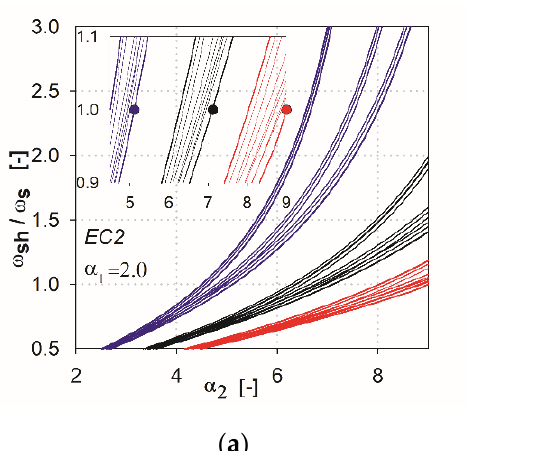
Figure 9. Graphs obtained for the parameter 𝛼 1 = 1.5 : ( a ) for the EC2 standard; ( b ) for the ACI code.